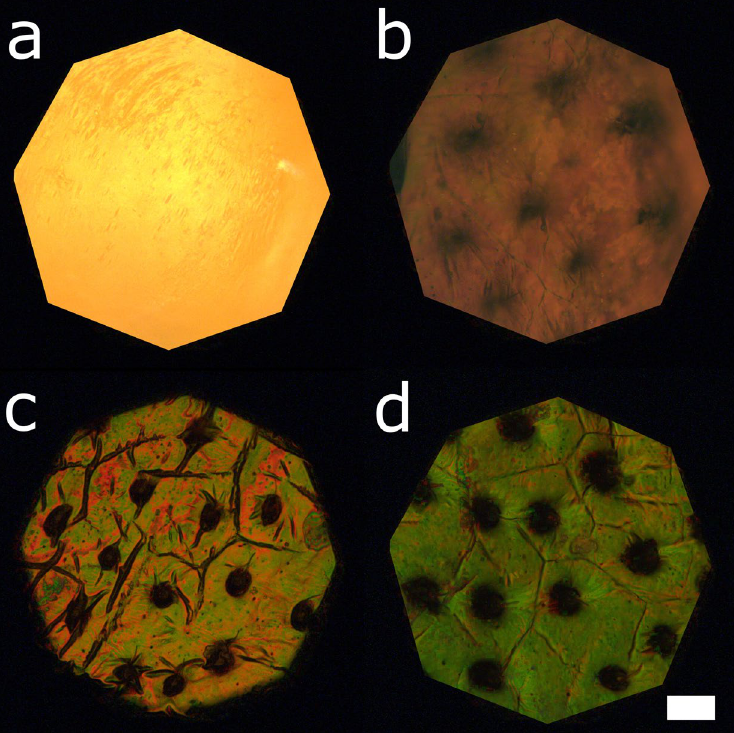
Figure 4. Micrographs of the developing cuticle. ( a ) shows the yellow pupal skin encasing the imago during pupation, when the cuticle is not yet formed. 3–4 days later ( b ), the adult cuticle is starting to form and is distinguishable underneath the pupal skin. The formation of trabeculae is evident from the presence of dark invaginations. In ( c ), the imago has emerged but the cuticle is still not fully expanded. 5 days after ecdysis ( d ), the cuticle has reached its final conformation. Scale bar: 1 mm.